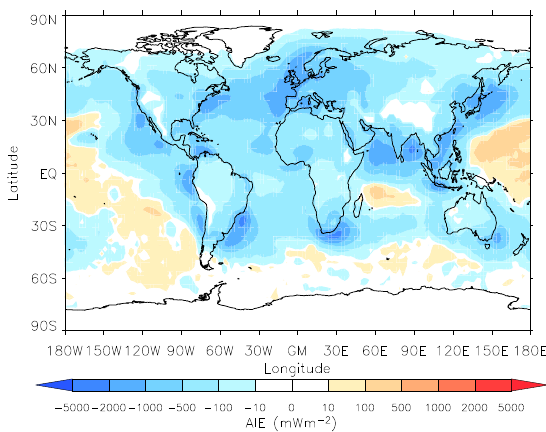
Fig. 6. Annual mean net (long wave and short wave) top of at- mosphere cloud-albedo aerosol indirect effect (AIE) due to pollu- tion (fossil fuel and biofuel) carbonaceous combustion aerosol for a cloud updraft velocity of 0.4ms − 1 .